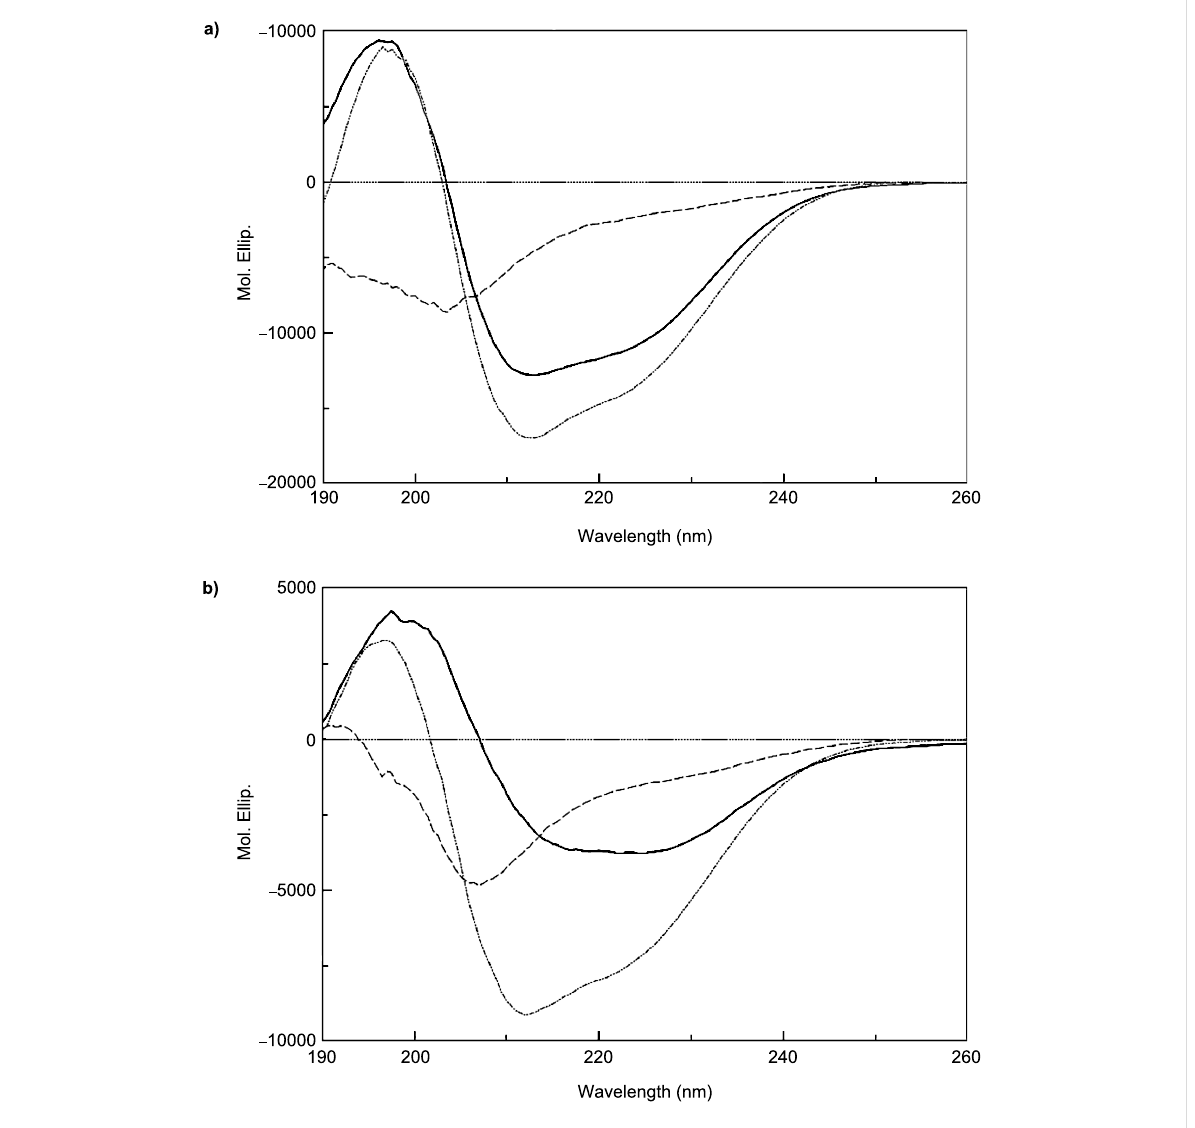
Figure 3: CD spectra of (a) carbopeptide 1 and of (b) carbopeptide 3 in: (i) 10 mM sodium phosphate buffer at pH 7.4 (broken line, - - -); (ii) 10 mM SDS in 10 mM sodium phosphate buffer at pH 7.4 (solid line, ___ ), and (iii) 50% (v/v) trifluoroethanol in 10 mM sodium phosphate buffer at pH 7.4 (broken dotted line, ·· − ·· −